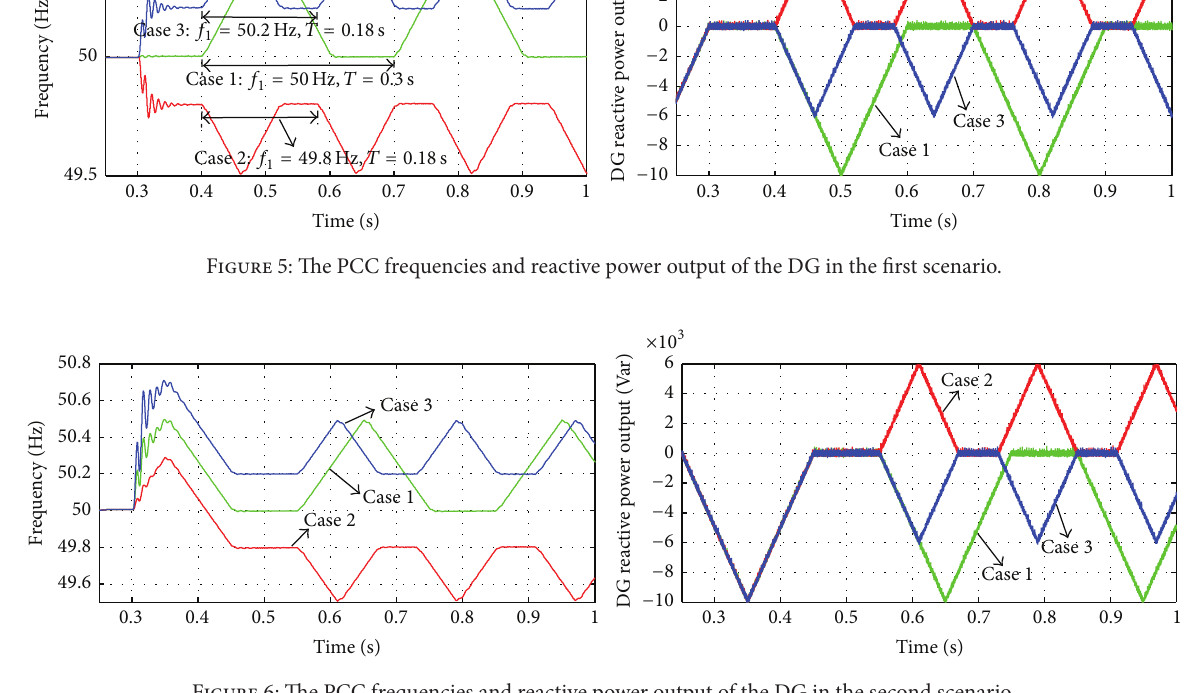
Figure 6: The PCC frequencies and reactive power output of the DG in the second